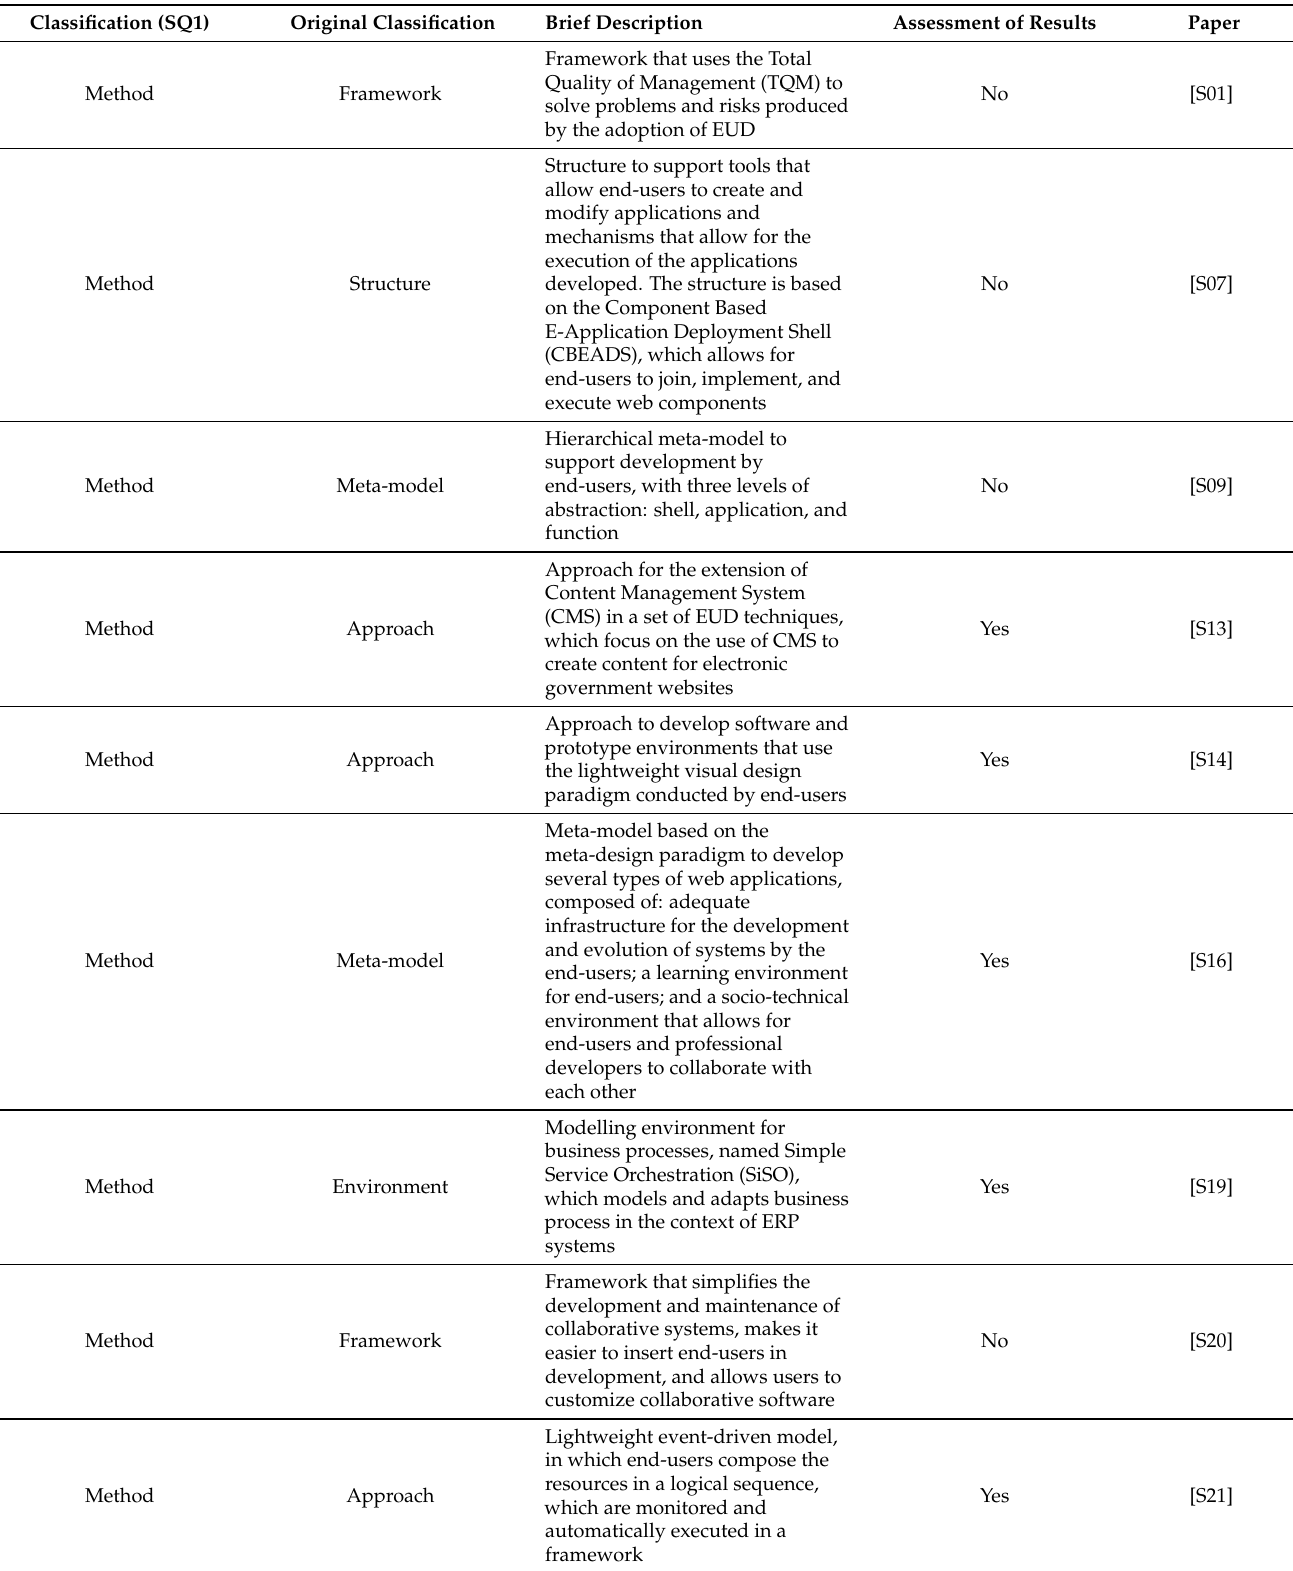
Table 5. Papers that answer